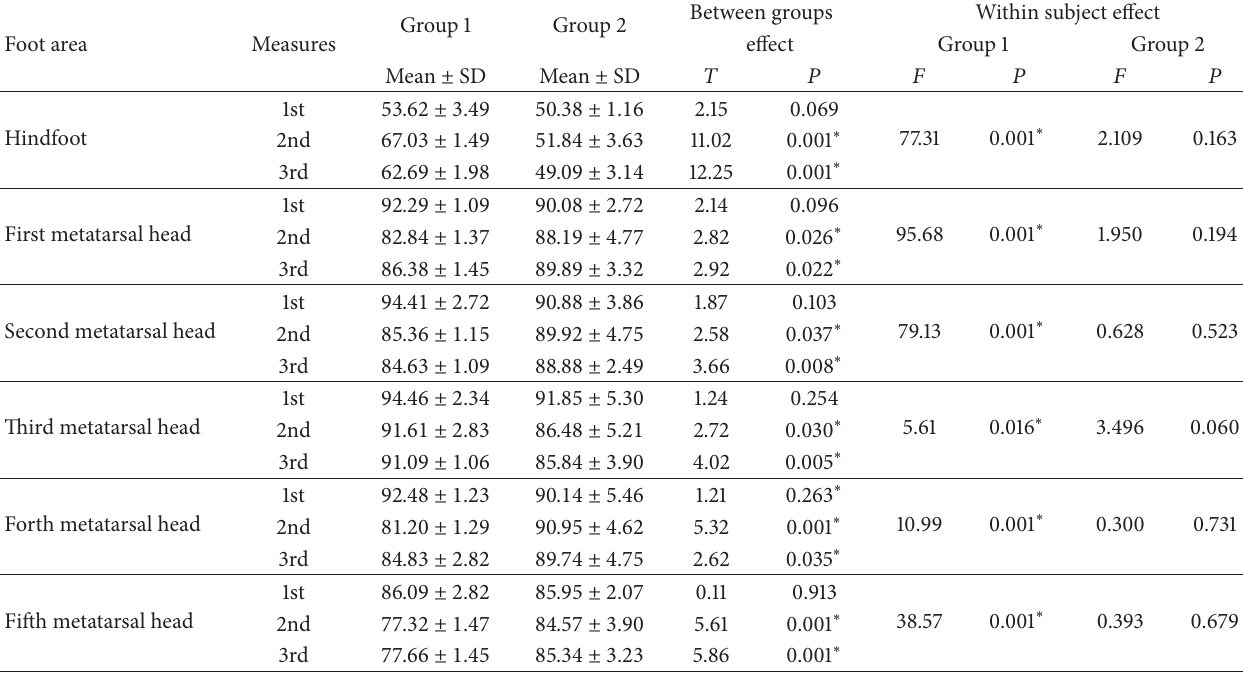
Table 3: Mean scores of time of contact (percentage average rollover period) for the study and control groups and the associated 𝑃 values for test of